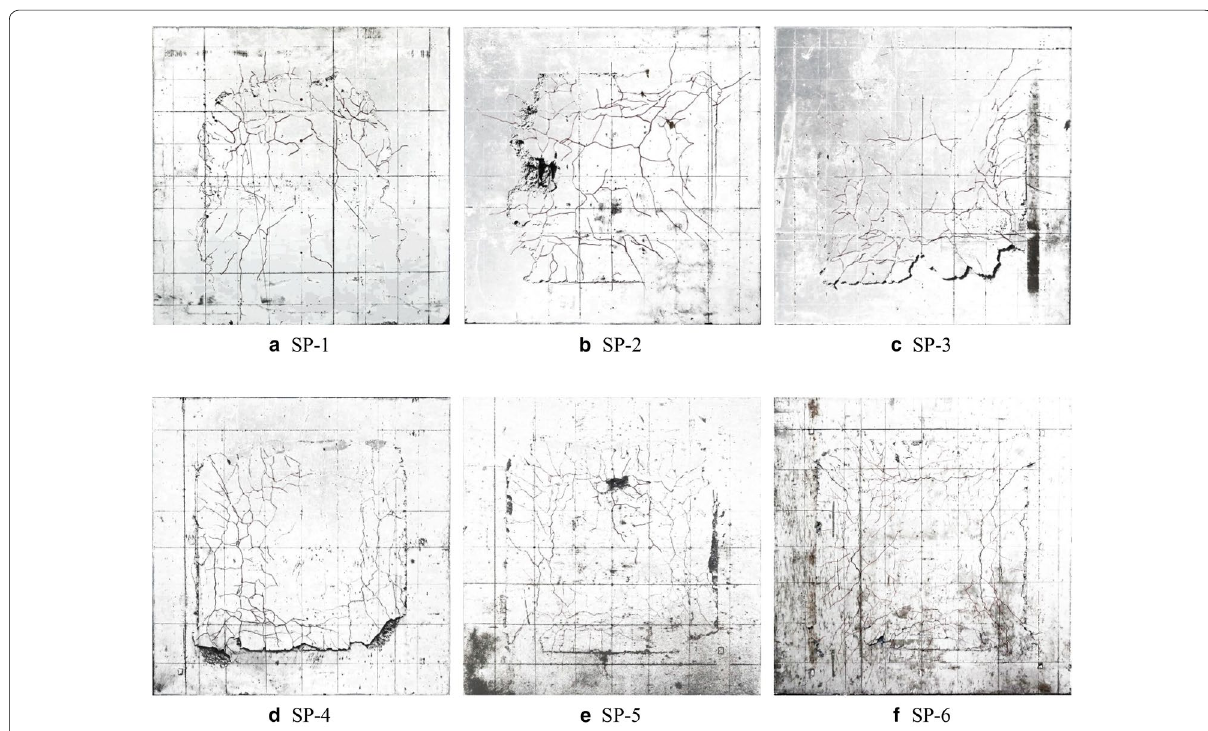
Fig. 5 Concrete cracks at the end of the